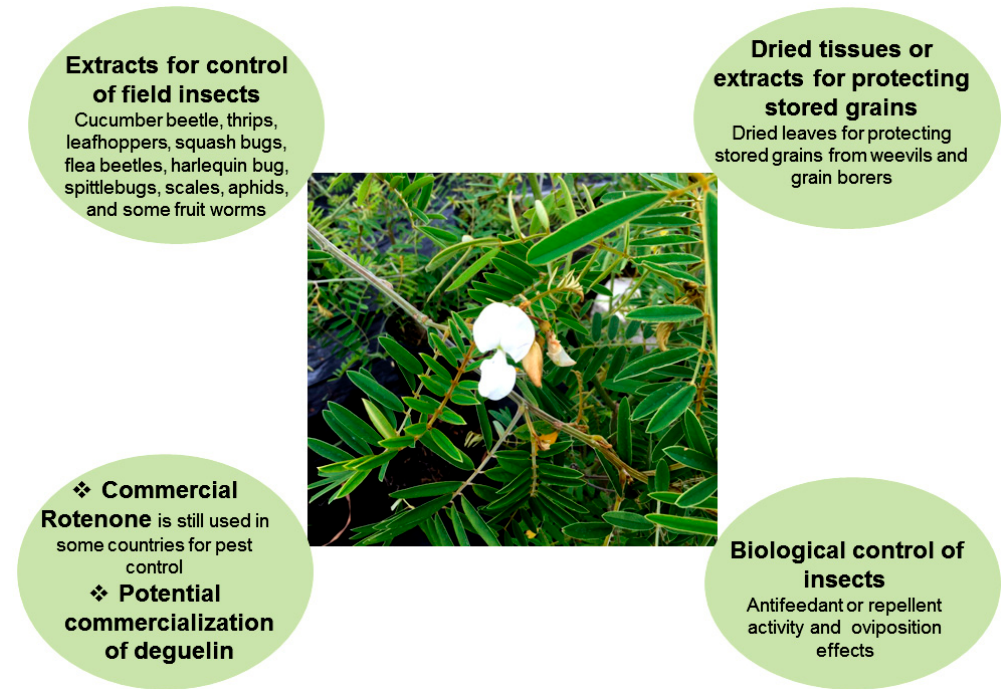
Figure 2. The use of Tephrosia plants for pest management .